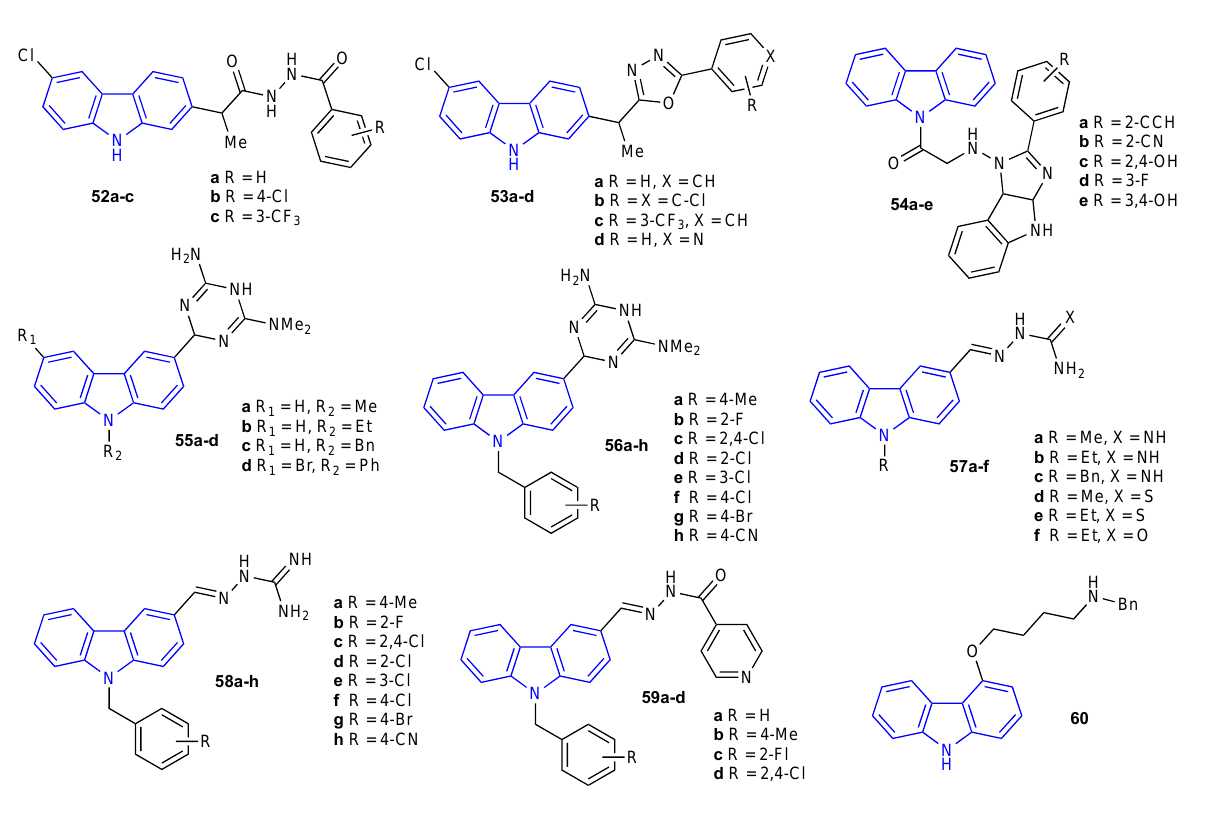
Figure 8. Structures of the reported carbazole derivatives from 2020 to 2022 .